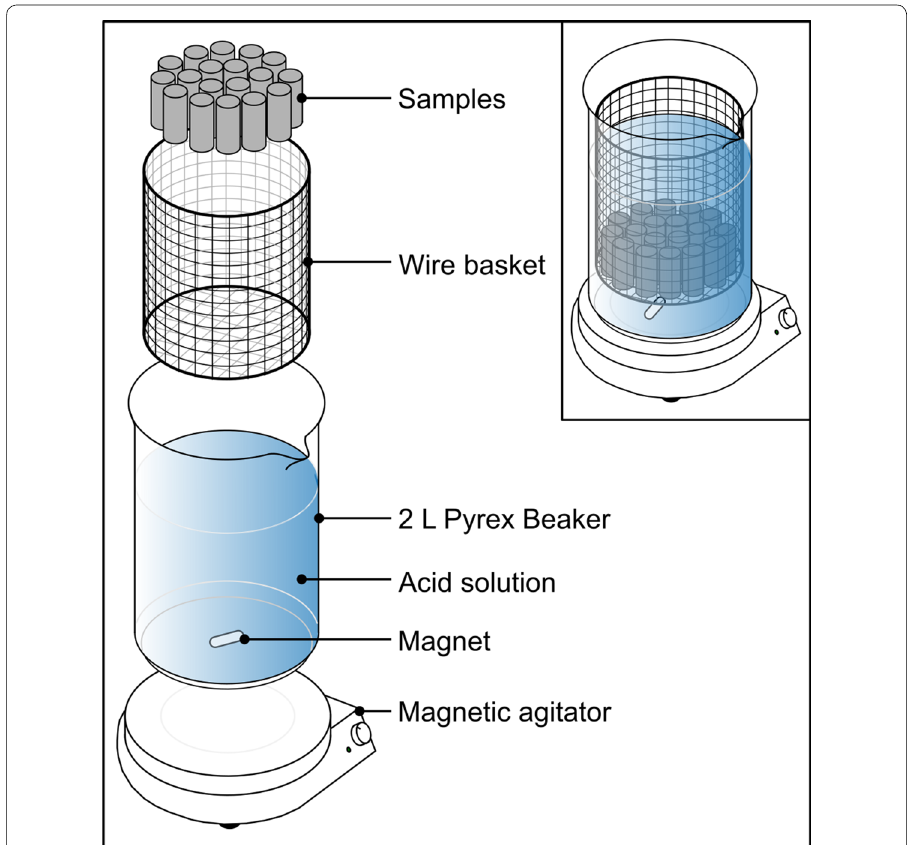
Fig. 3 Schematic of batch acid immersion experimental